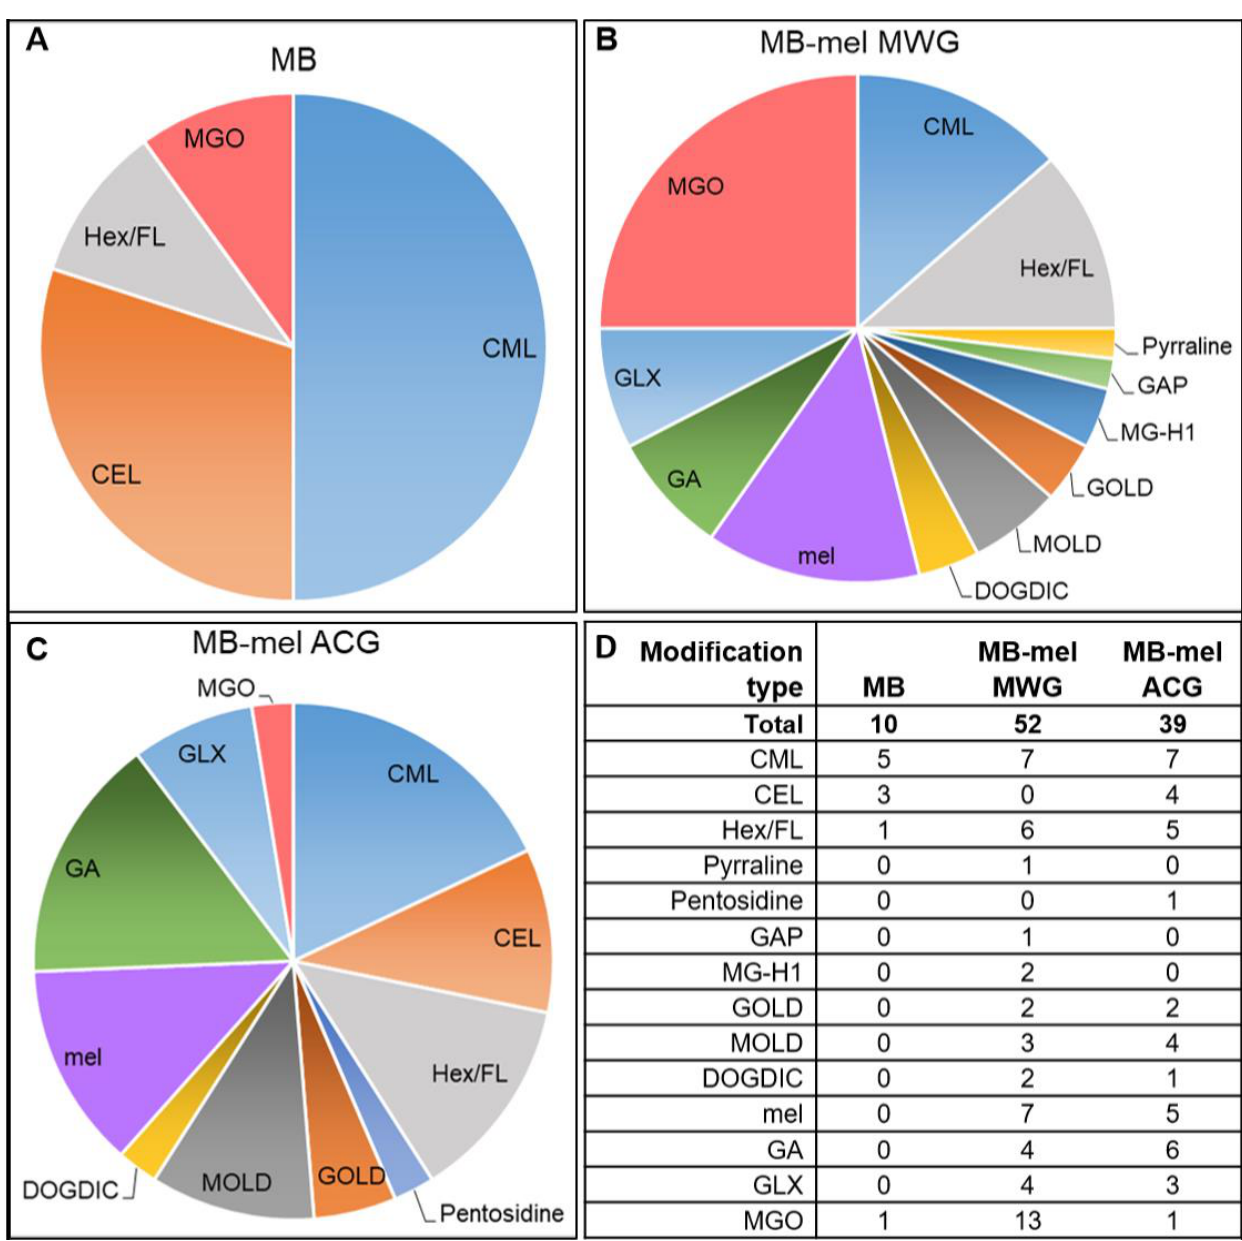
Figure 4. Comparison of the modification incidents (modified residues containing the indicated modification) identified in native MB protein ( A ) and MB-mel obtained in dry (MWG) ( B ) or aqueous glycation (ACG) ( C ) conditions. The number of identified modifications is presented in table ( D ).